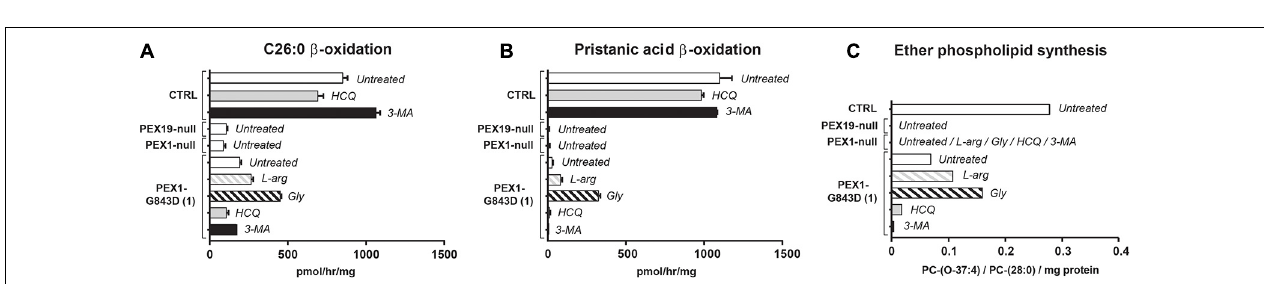
FIGURE 3 | Autophagy inhibitors do not restore peroxisomal metabolic functions in primary PEX1-G843D fibroblasts. Peroxisomal β -oxidation activity of C26:0 (A) and pristanic acid (B) , and (C) de novo synthesis of the ether phospholipid PC-(O-37:4) determined in primary fibroblasts from a PBD-ZSD patient homozygous for the PEX1-G843D mutation (PEX1-G843D(1)) and a control individual (CTRL) treated as described in Figure 1A . For reference we included the peroxisomal β -oxidation activities and the de novo PC-(O-37:4) synthesis values measured in untreated primary fibroblasts from a PBD-ZSD patient without residual PEX1 function (PEX1-null; still containing peroxisomal membranes) and from a PBD-ZSD patient without residual PEX19 function (PEX19-null; lacking peroxisomes entirely). β -oxidation activities are expressed as pmol/hr/mg protein and as mean + SD ( n = 3); ether phospholipid synthesis is expressed as PC-(O-37:4) over PC-(28:0) over mg protein (mean of two measurements); PC-(28:0) was used as internal standard.